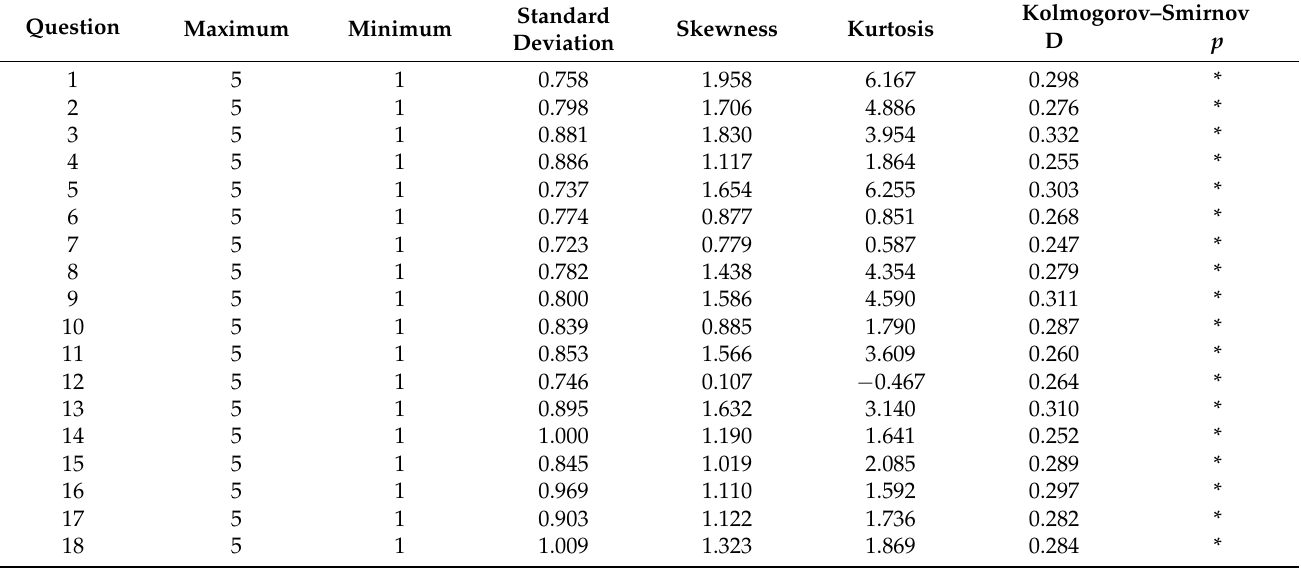
Table 3. The result of measures statistical